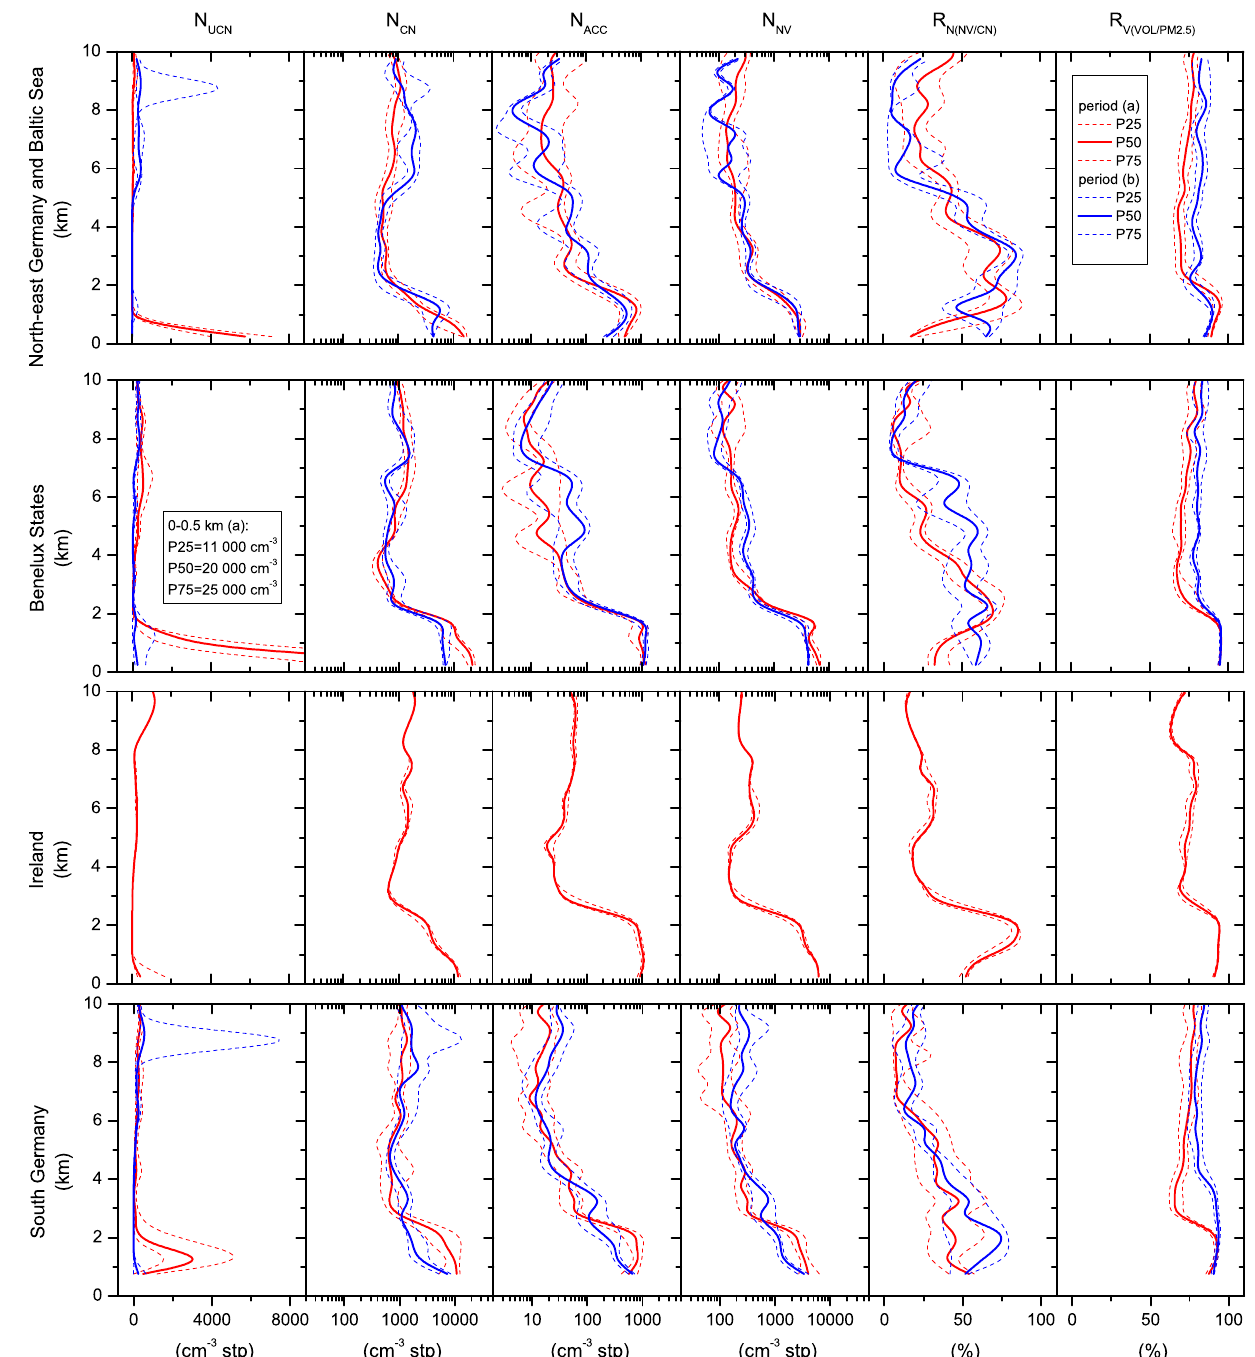
Fig. 5. Vertical profiles of number concentration of particles in diameter D P 0.004–0.01µm N UCN , D P > 0.01µm N CN , D P 0.15–1.0µm N ACC , and particles containing a non-volatile core N NV (250 ◦ C). All number concentrations are reported in particlescm − 3 at standard temperature and pressure (stp). In addition, number fractions of non-volatile particles R N NV / CN and volume ratios of volatile matter R V VOL / PM2 . 5 are given in %. The red (blue) line shows values for the period between 1–15 (16–31) May, i.e. period (a) and (b) . Each vertical profile contains median and 1st and 3rd